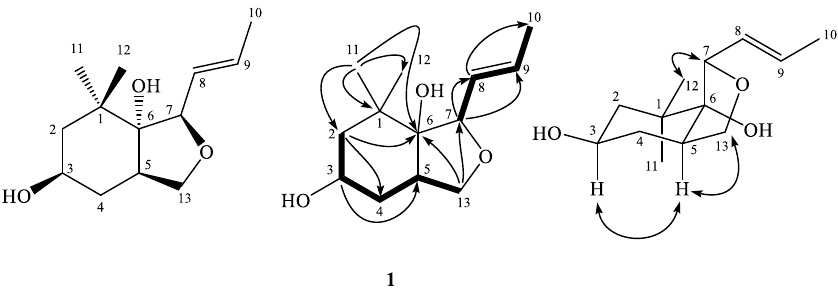
Figure 1. Key COSY ( ▬ ), HMBC ( → ), and NOESY ( ↔ ) correlations of 1 .